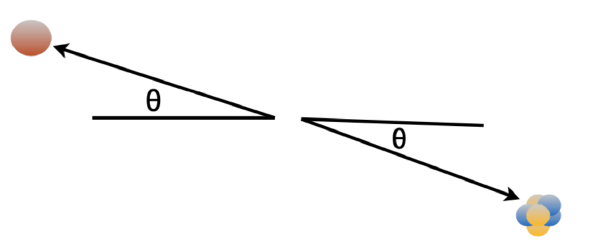
Figure 3: WIMP-nucleus scattering in the center-of-mass